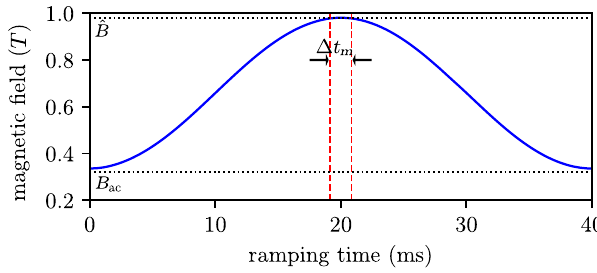
FIG. 13. The magnetic field ramping in one cycling period in CSNS-II/RCS. The dotted lines denote the amplitude of the ˆ B maximum and the ac component B confused with the minimum magnetic field dashed red lines represent the duration time of the merging